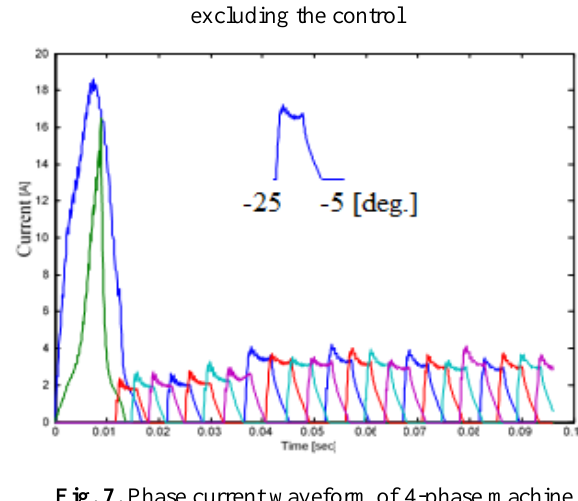
Fig. 6. Phase current waveform of 4-phase machine excluding the control